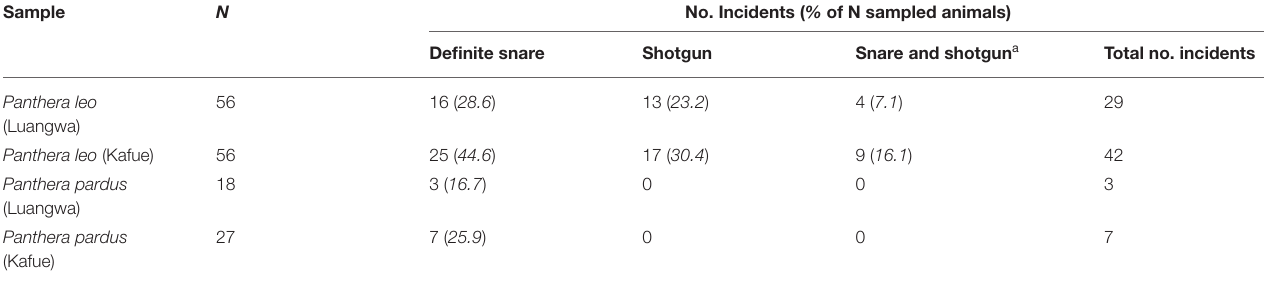
TABLE 2 | Number and type of anthropogenic injuries in lions and leopards by region. Sample N